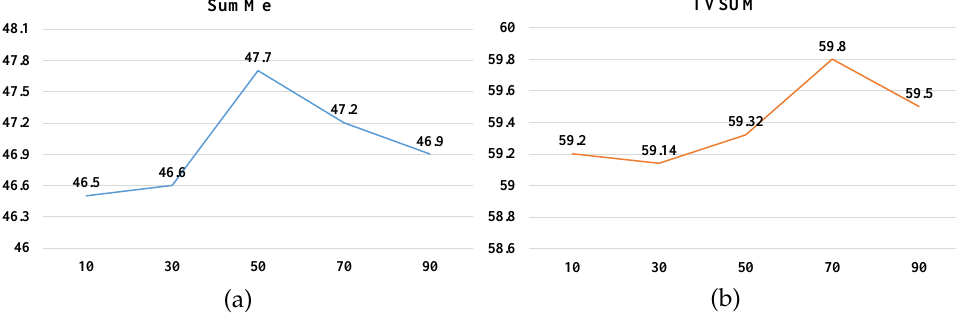
Figure 8. Performance with different subsequence lengths N on two datasets: ( a ) SumMe dataset and ( b ) TVSum dataset. The x-axis represents the percentage of video length and the y-axis represents the F score. Table 8. Performances with different CNN encoders on two